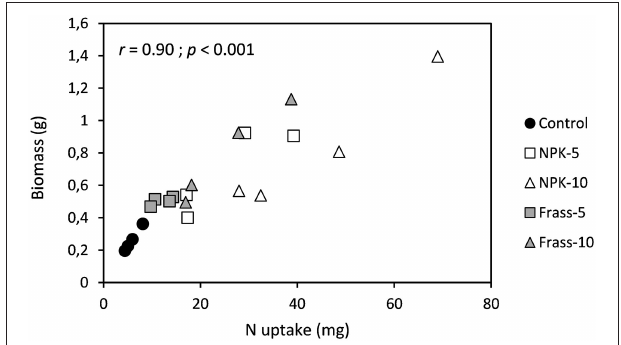
FIGURE 2 | Relationship between biomass and nitrogen (N) uptake in ryegrass. Marked r correlation coefficient is the Pearson’s correlation coefficient.